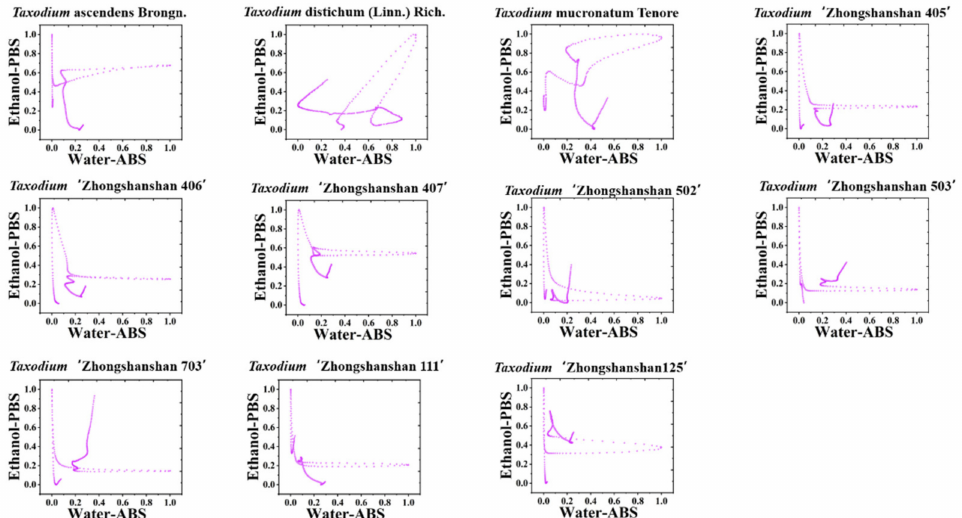
Figure 3. Scatter plots of T. ascendens, T. distichum, T. mucronatum, T. ‘Zhongshanshan 405’, T. ‘Zhongshanshan 406’, T. ‘Zhongshanshan 407’, T. ‘Zhongshanshan 502’, T. ‘Zhongshanshan 503’, T. ‘Zhongshanshan 703’, T. ‘Zhongshanshan 111’, and T. ‘Zhongshanshan 125’ combining the signals collected under ABS for the water extracts and under PBS for the ethanol extracts.